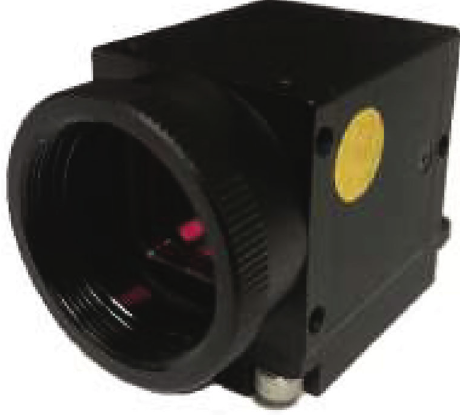
Figure 2: COMS industrial